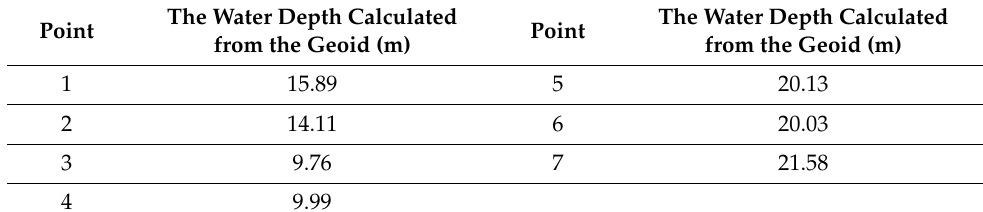
Table 6. The seven chosen reference points, which are marked in Figure 4 with